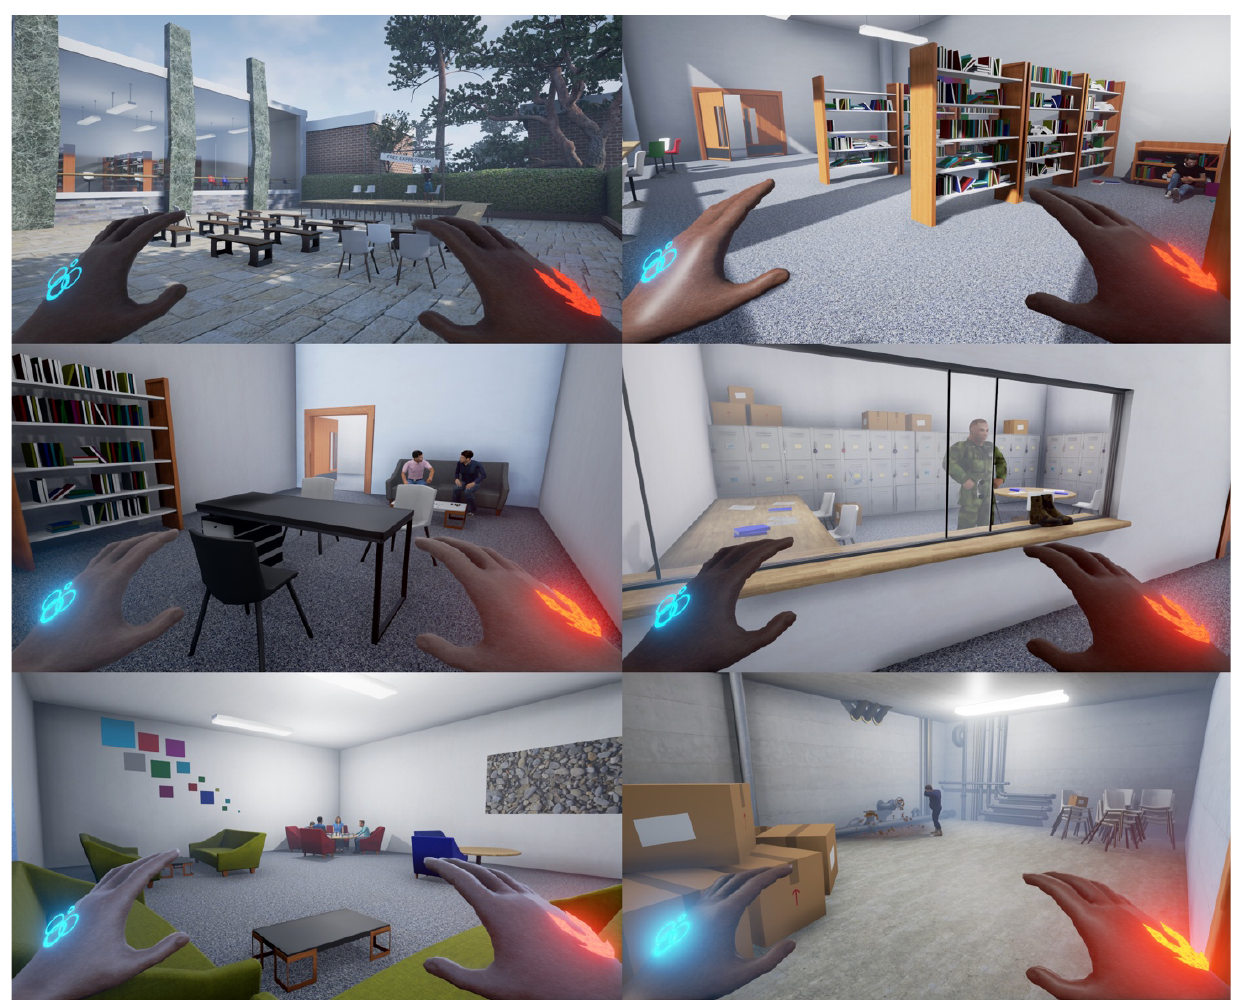
Figure 1. The six in-game MFT scenarios. Note: Top left clockwise—L/O, C/H, A/S, S/D, L/B, and F/C. with the sub-measure Guilt score obtained from 6 items within the Negative Affect scale. The scale range in- cluded: 1 = Very slightly, to 5 = Extremely (Watson & Clark,